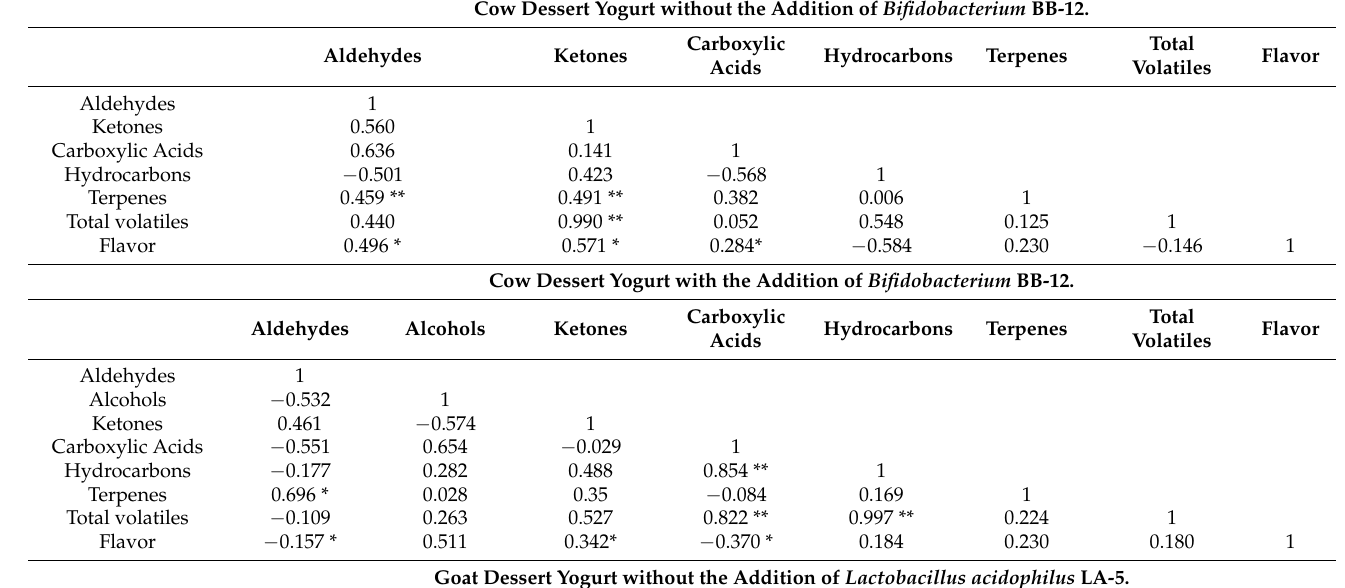
Total Volatiles